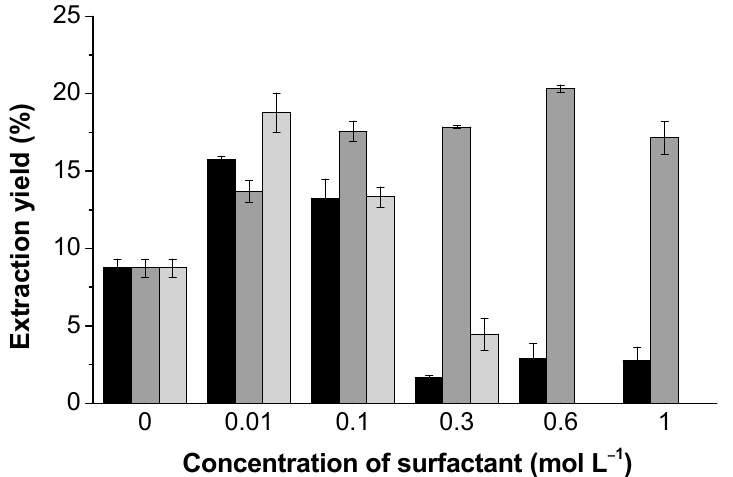
Figure 7. Yield of the recovered lignin using different concentrations of SDS (black), hexadecyltrimethylammonium bromide (CTAB) (gray), and PS20 (light gray).